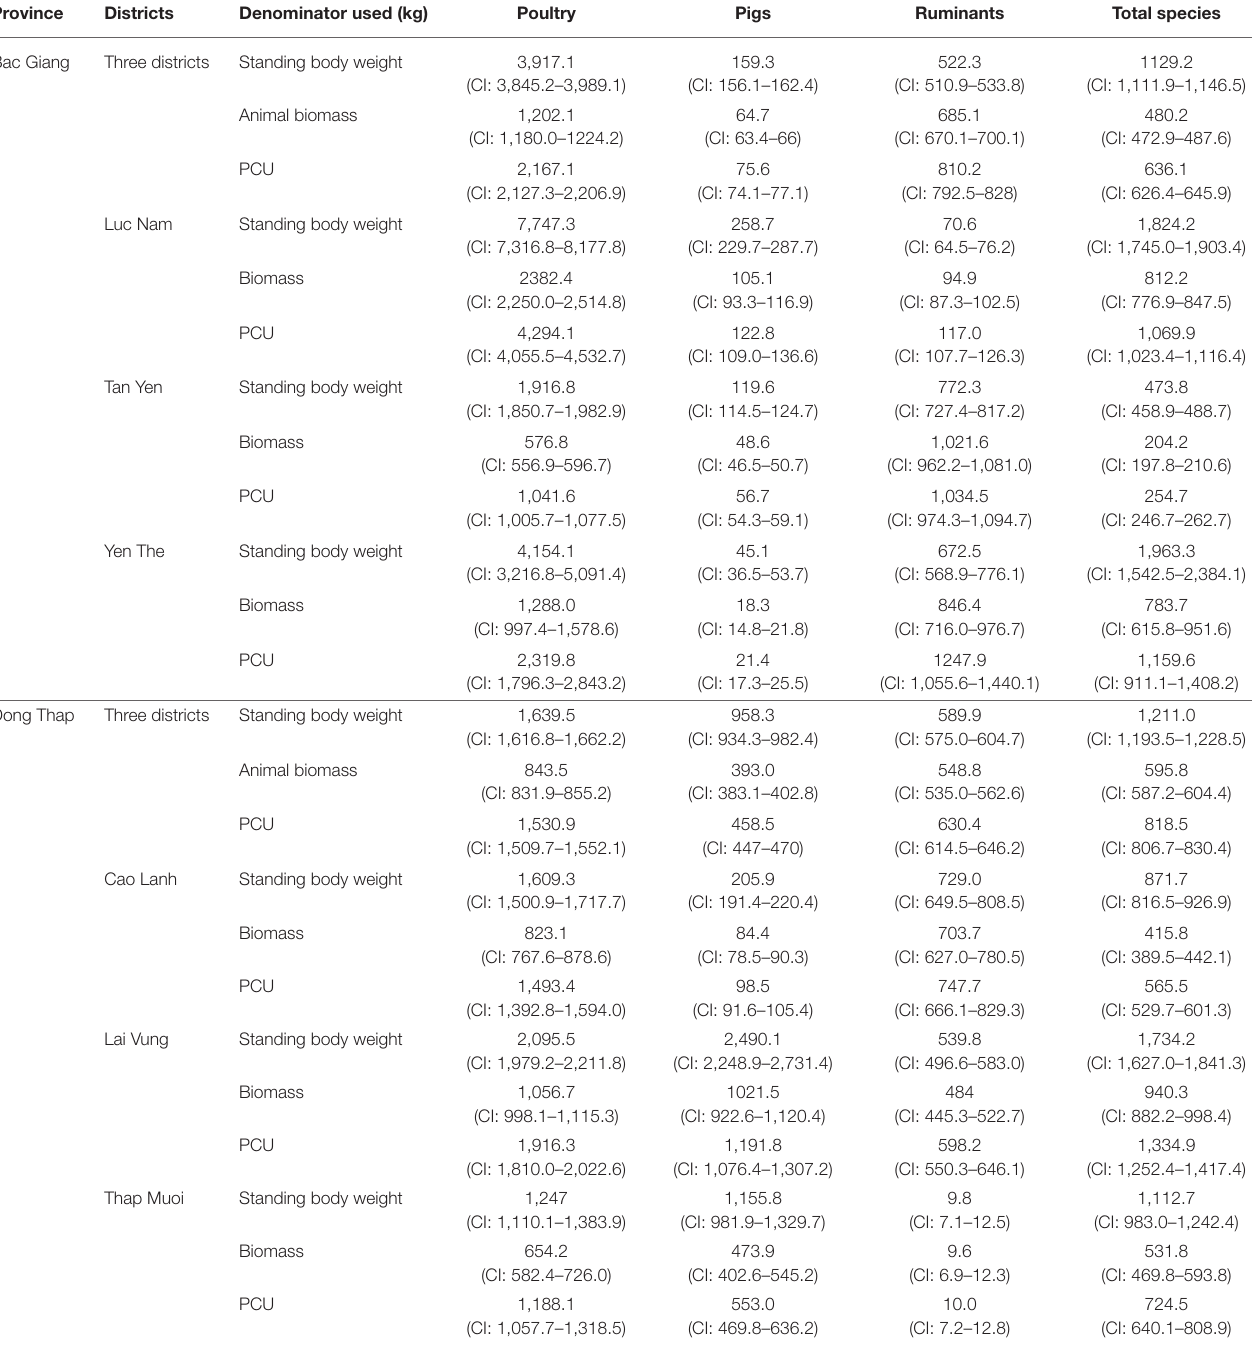
TABLE 4 | Total annual AMU sales following species in three districts of Bac Giang and Dong Thap province (Unit: mg/kg).